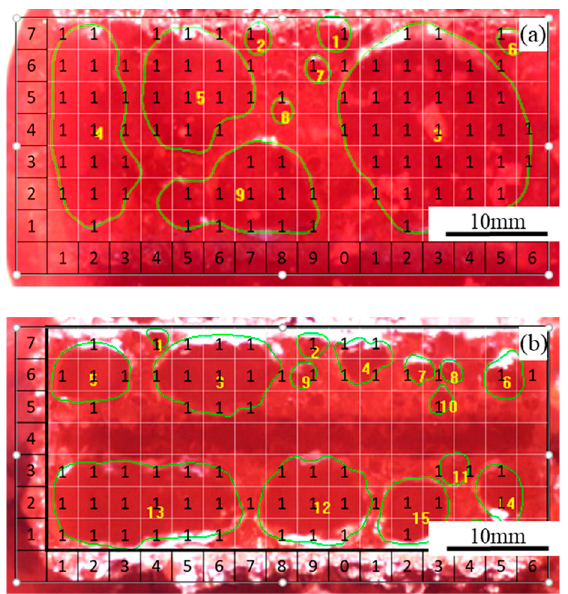
Figure 2. Two images obtained during electrolysis on ( a ) flat anode and ( b ) slotted anode under apparent anode current density of 0.9 A ‧ cm − 2 in Experiment 1 (refer to Table 1).